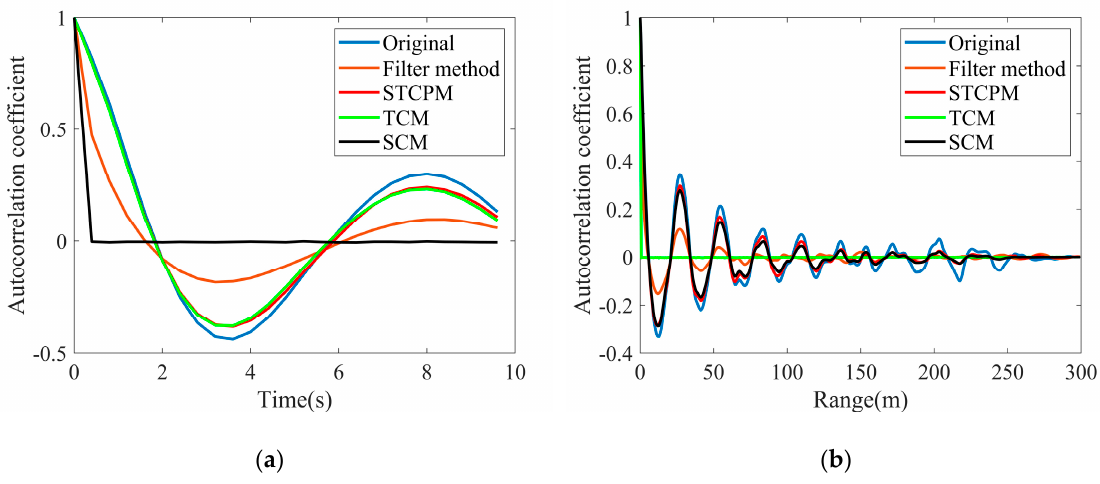
Figure 11. Average correlation coefficients of texture: ( a ) Temporal correlation; ( b ) Spatial correlation.